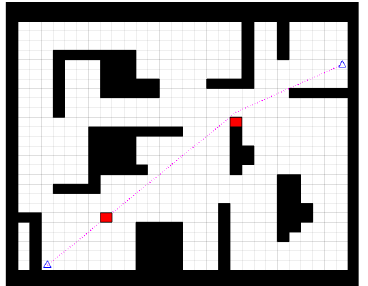
Figure 14. The addition of temporary obstacles to the global path.